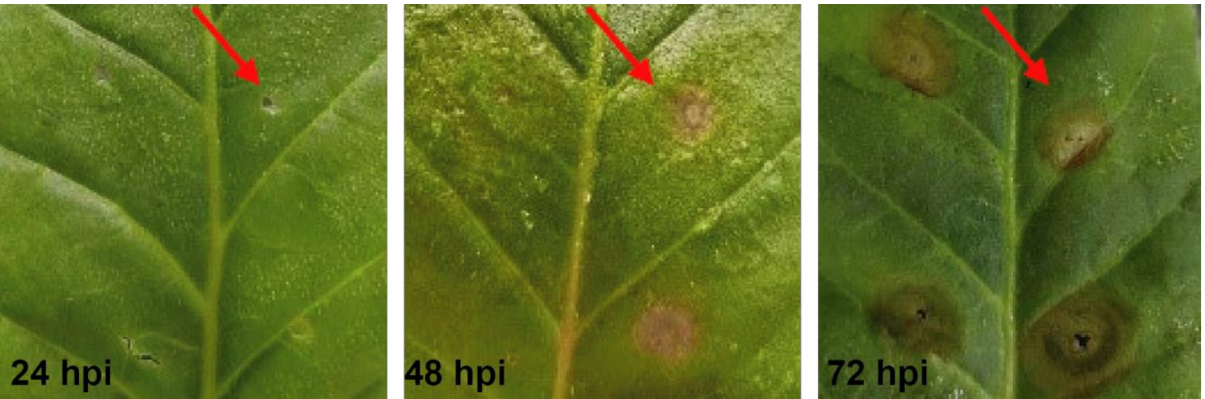
Figure 1. The symptoms of Nicotiana tabacum inoculated with R. solani AG-3 TB. Red arrows were symptoms of R. solani AG-3 TB infection. Table 1. The lesion diameter of needle point on N. tabacum inoculated with R solani AG-3 TB. Hours Post Inoculation